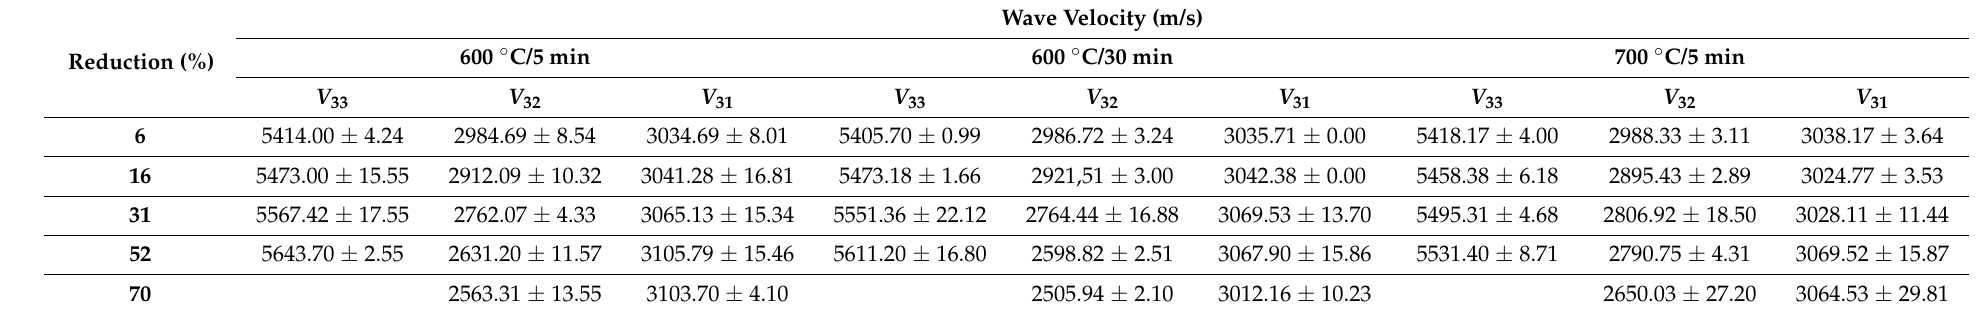
Table 5. Wave velocities after recrystallization annealing cold-rolled specimens.